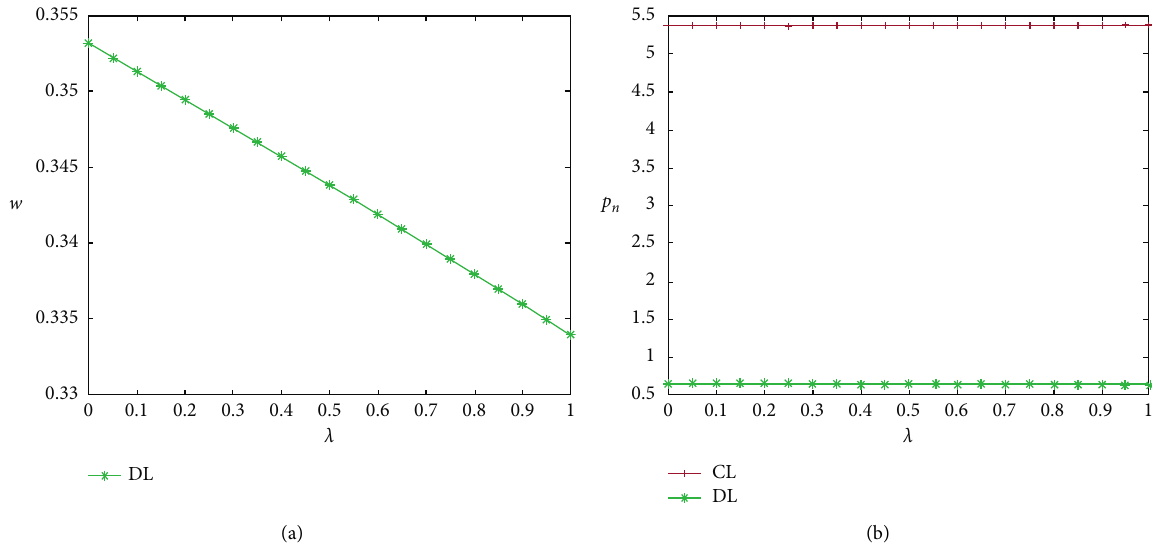
Figure 1: Effect of regret sensitivity coefficient on wholesale and retail